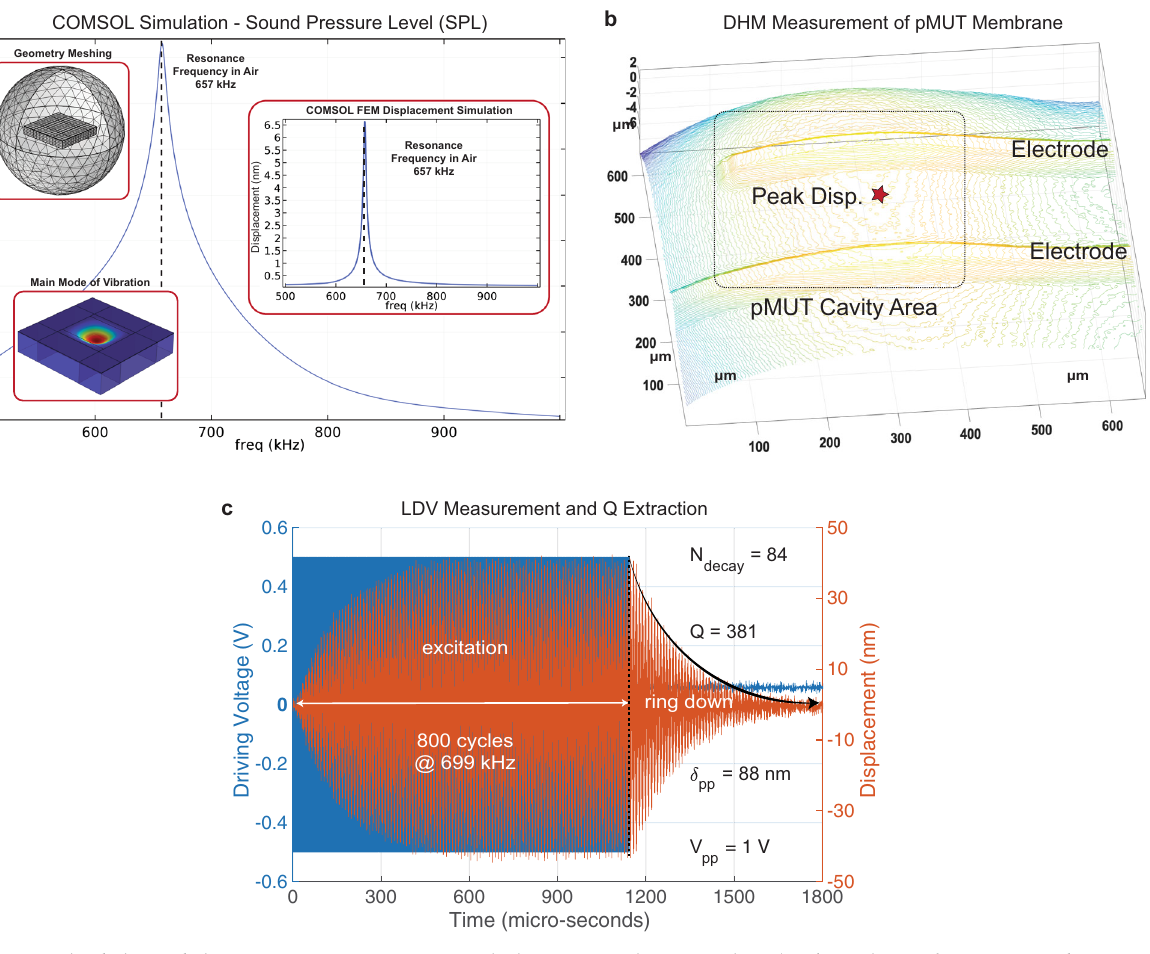
Fig. 6 LN pMUT simulation and air measurements. a COMSOL Multiphysics Finite Element Analysis (FEA) simulation of an LN pMUT. b DHM measurement of the pMUT membrane displacement and its 3D reconstruction for mode analysis. c Quality factor extraction from the displacement of the pMUT membrane with the ring-down